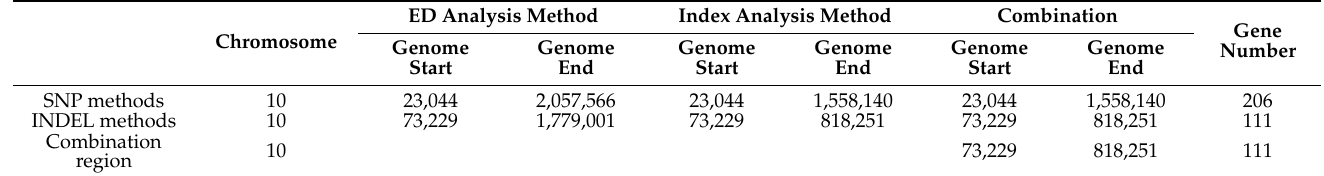
Table 3. The linkage region using by two calculations with 2 analysis